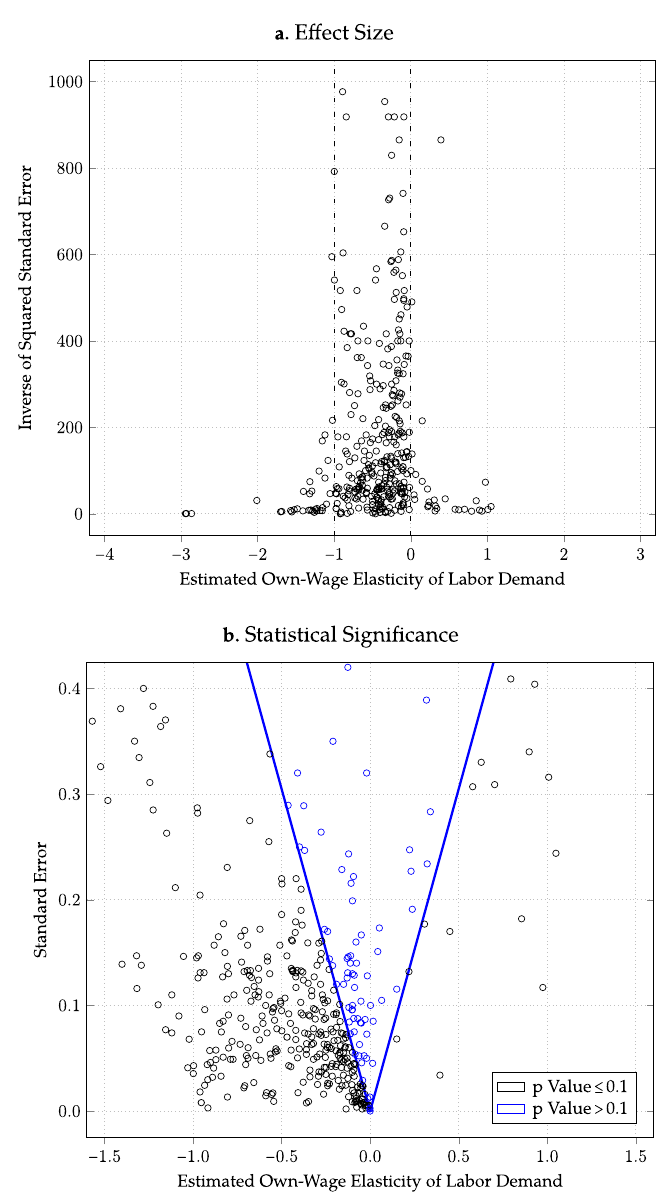
Fig. 2 Funnel Plots. The figure shows funnel plots to examine publication bias regarding own-wage elasticities of labor demand from the German labor market. Specifically, the figures plot point estimates of own-wage elasticities of labor demand against the underlying (inverse of the squared) standard error. In the absence of publication bias, low-precision estimates are supposed to be widely dispersed. The graphs are truncated at the axis edges. In Panel b , the blue funnel indicates the 10% significance level (t = ± 1.64 ). Source: Own